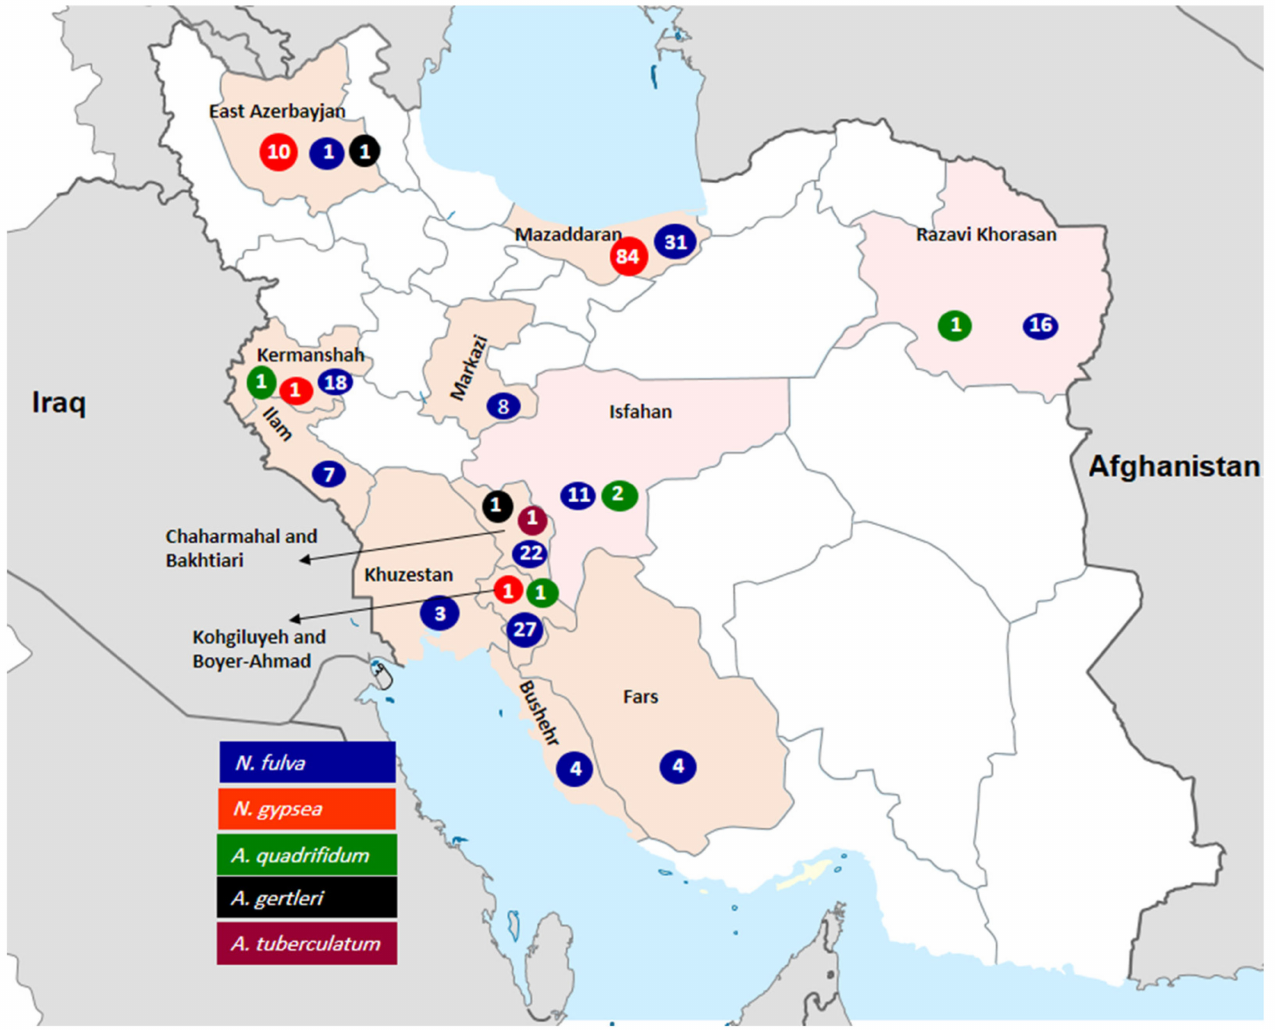
Figure 1. Frequency and distribution of isolated geophilic species according to the geographic